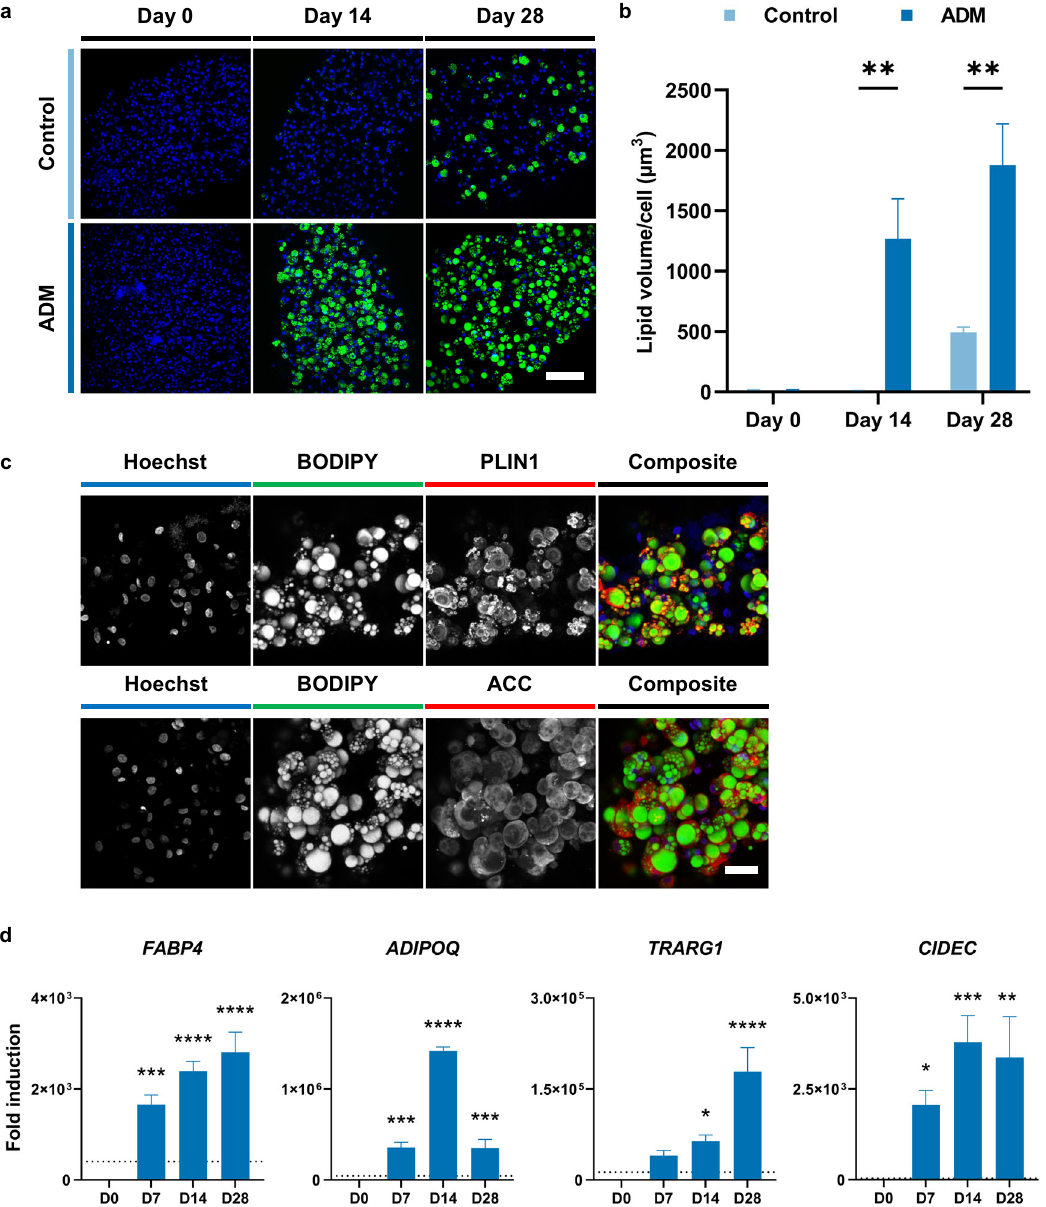
Fig. 4 Adipogenic differentiation of FAPs in 3-dimensional hydrogels. a Maximum intensity projection confocal microscopy images of control (top) and ADM (bottom panels) treated FAP micro fi bres after 0, 14, and 28 days of differentiation. Green = BODIPY, blue = Hoechst, scale bar = 100 µm. b Lipid volume per cell, for samples in a (quanti fi ed by calculating total lipid volume from BODIPY immuno fl uorescence, divided by number of nuclei, for three independent images). Condition (i.e., control vs ADM) post-hoc signi fi cance in a two-way ANOVA is indicated (condition, time, and their interaction are all statistically signi fi cant). c Maximum intensity projection confocal microscopy images of FAP micro fi bres after 28 days of differentiation. Green = BODIPY, blue = Hoechst, red = PLIN1 (top) or ACC (bottom panels). Scale bar = 40 μ m. d Expression of adipogenesis-related genes in FAP micro fi bres after 0, 7, 14, and 28 days of adipogenic differentiation, measured by RT-qPCR. Data was normalised to the expression on Day 0. Dashed line indicates extent of upregulation after 14 days of 2D differentiation (Fig. 3e). All numerical data is shown as mean ± sd ( n = 3); P -values: * P ≤ 0.05; ** P ≤ 0.01; *** P ≤ 0.001; **** P ≤